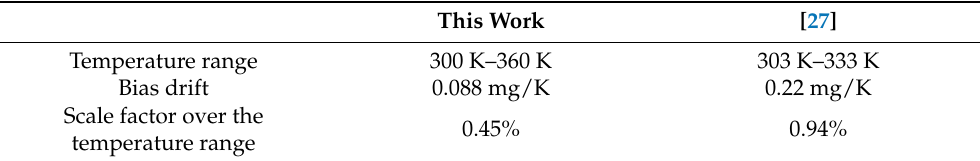
Table 2. Comparison with work